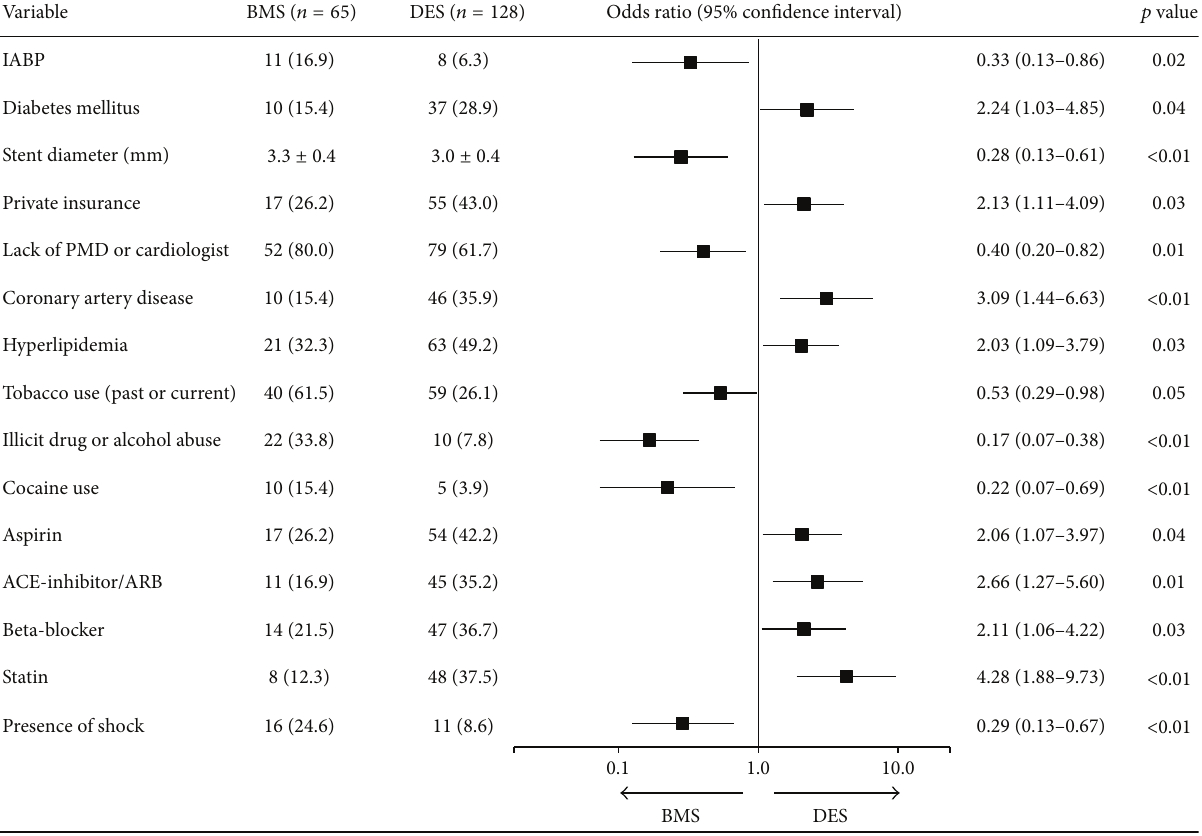
Figure 1: Bivariate logistic regression of factors associated with DES or BMS. Factors significantly associated with BMS use include the presence of shock, placement of an intra-aortic balloon pump (IABP), larger stent diameter, lack of primary care provider (PMD) or cardio- logist, tobacco use, illicit drug or alcohol abuse, and cocaine use.